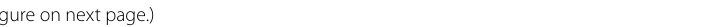
figure on next Fig. 6 LY333531 inhibited the immune maturation of DCs and alleviated atherosclerosis in diabetic ApoE − / − mice. The expression of the co-stimulatory molecules, CD83 and CD86, in splenic DCs was inhibited in the LY333531 group ( a ). The qPCR results also indicated that the expressions of TNFα, IL12b, IL6, CCL4, CCR7, and CXCR4 were inhibited in DCs, while the expression of IL10 was increased ( b , c ). In the LY333531 group, not only were the aortic adhesion molecules, ICAM1 and VCAM1, inhibited ( d ), but inflammatory markers such as TNFα, IFNγ, and CRP also were inhibited in peripheral blood ( e , f ). Systemic administration of LY333531 delayed the formation of aortic root plaques in mice with diabetic atherosclerosis when compared with the control group ( g ). Masson staining revealed that the collagen fiber composition in the plaques increased ( h ). Staining of cells in the plaque indicated that the distribution of inflammatory cells was decreased after LY333531 administration. Co-staining of CD68 and CD14 with CD11c showed that after excluding the influence of macrophages and monocytes, CD11c-labeled DCs had a significant reduction in plaques ( i , j ). Values, mean SED; n 8; *p < 0.05 vs. ApoE DM group; DM Diabetes mellitus, IL Interleukin, ICAM Intercellular adhesion ± = + molecule, VCAM Vascular cell adhesion molecule, TNFα Tumor necrosis factor alpha, IFNγ IFN gamma, AS Atherosclerosis, DAPI 4,6-diamino-2-phenyl